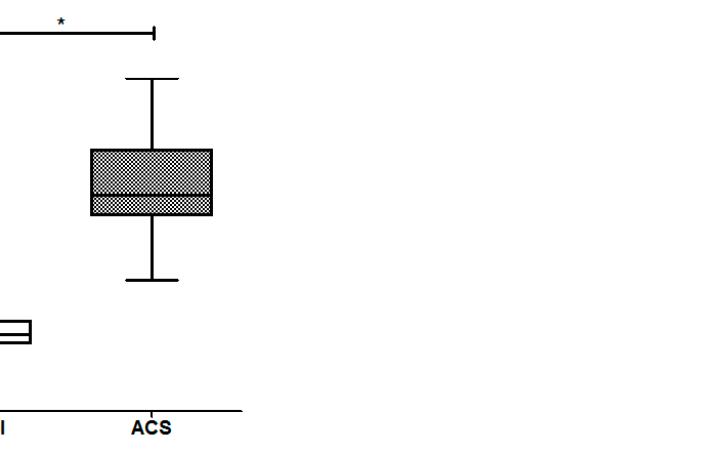
Figure 4. Percentage of HDL denaturation after 8 h of incubation with urea 8 M, in ACS patients ( n = 24) and controls ( n = 20). Data are represented as the median (line horizontal) and interquartile range (boxes). Mann–Whitney U test. * p < 0.05.